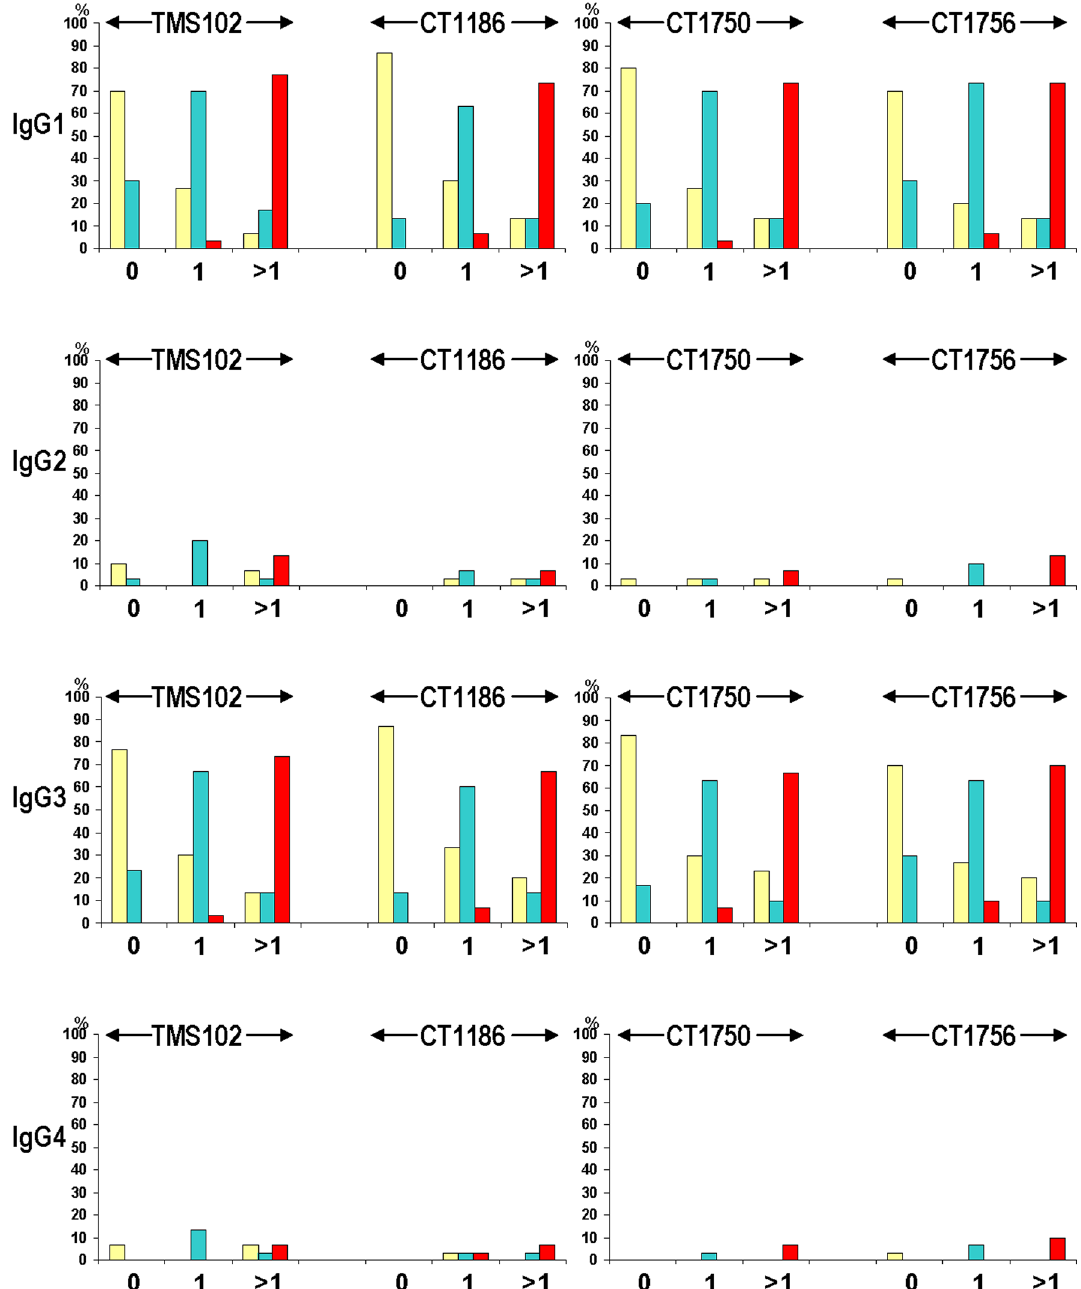
Figure 3. Distribution of avidity levels of IgG isotypes against PvMSP9 antigens and the number of previous malaria episodes. Vertical axis represents percentage of seropositive patients. Patients are classified as those who had prior 0, 1 and 2–4 (shown as > 1) malaria episodes. Low, intermediate and high avidity antibodies are shown in light yellow, turquoise and red bars, respectively. The percentages of high avidity IgG1 and IgG3 antibodies to all antigens display an increasing trend toward an increasing number of previous malaria episodes ( χ 2 for trend, p <